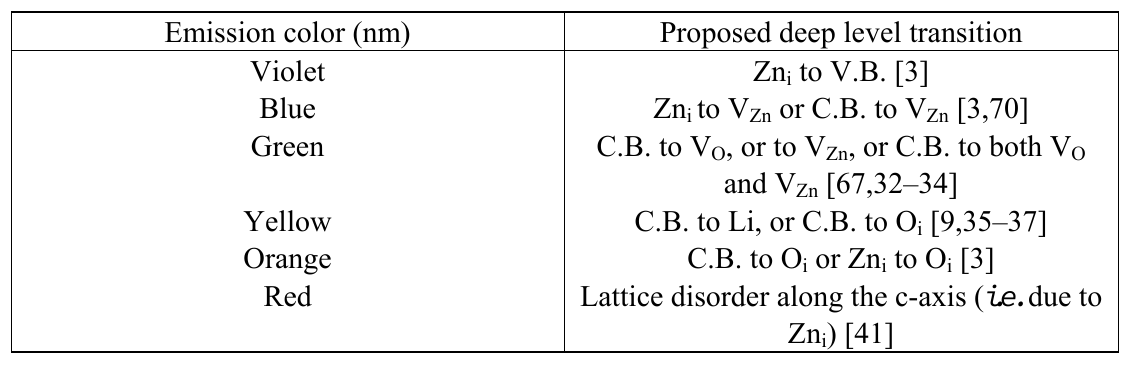
Table 1. Some recently reported lines emitted from ZnO and the proposed associated deep level defect(s) causing the emission. The conduction and valence bands are abbreviated in the usual way as C.B. and V.B.,